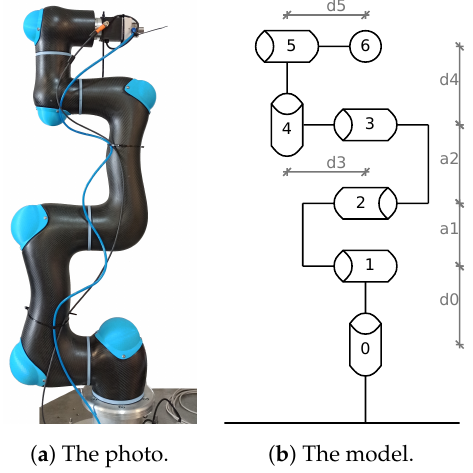
Figure 1. The CURA6 robot. Table 1. DH parameters of